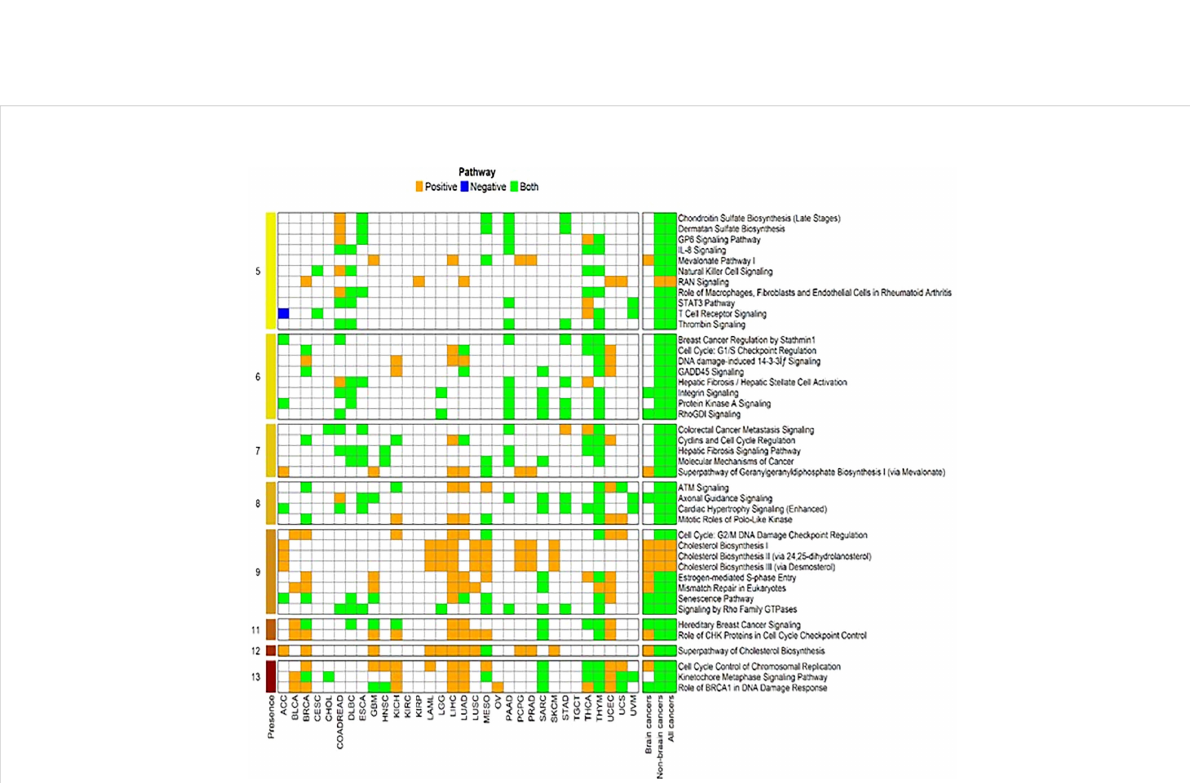
FIGURE 5 Enriched canonical pathways for genes associated with FADS1. The canonical pathway analysis was performed using Ingenuity Pathway Analysis (IPA, Qiagen, USA) package for each cancer type and the signi fi cant pathways were selected at an unadjusted P<0.05. Then we further fi ltered in the signi fi cant canonical pathways that were present among at least 5 individual cancer types. After that, for each cancer type and each selected signi fi cant canonical pathway, we identi fi ed genes that were a member of the corresponding pathway and were signi fi cantly associated with the expression level of FADS1. For each selected pathway, among these identi fi ed genes, we indicate as ‘ Positive ’ if all genes have the positive correlation with FADS1 for each cancer type, ‘ Negative ’ if all genes have the negative correlation, and ‘ Both ’ otherwise. The numbers in the leftmost indicate the total number of cancer types where the corresponding signi fi cant canonical pathway was